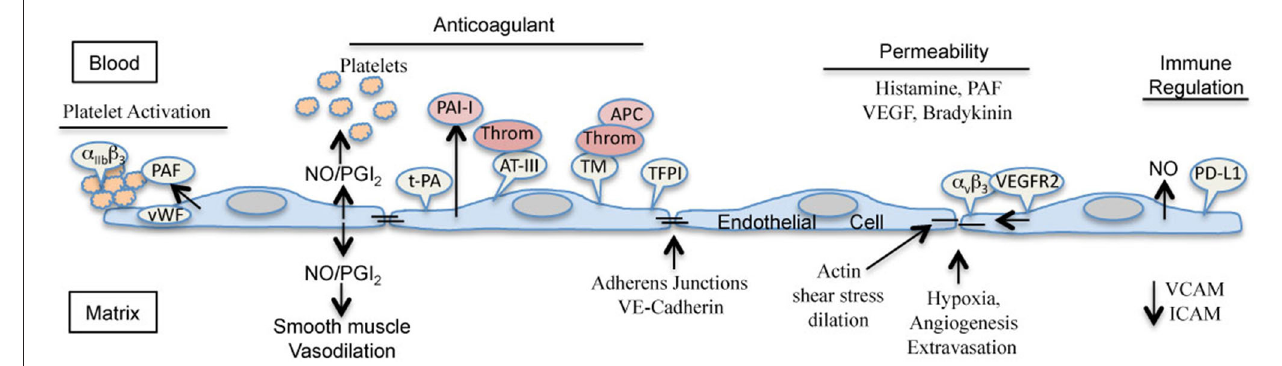
FIGURE 1 | Endothelial cell functions that maintain hemostasis. Endothelial cells are primary anticoagulants that prevent platelet and immune cell adherence and restrict the activation of clotting cascades (Hoffman and Monroe, 2001; Feletou, 2011). ECs display tissue plasminogen activator